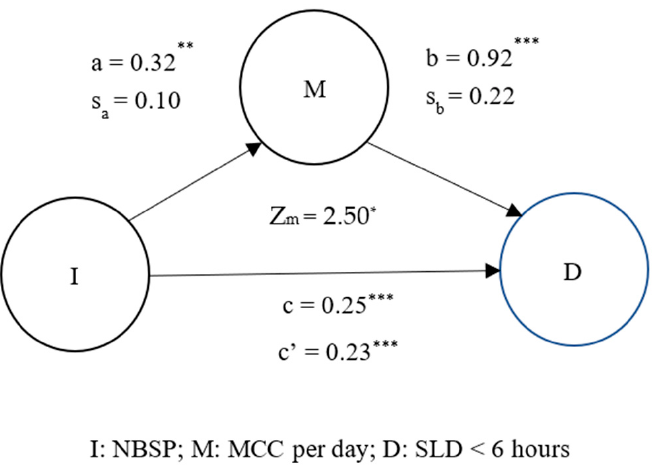
Figure 3. Mediation effect of MCC per day on NBSP and SLD < 6 h. * p < 0.05; ** p < 0.01; *** p < 0.0001; M, mediation factor; I, independent variable; D, dependent variable; c is the simple linear or logistic regression coefficient for the independent variable against dependent variable in the absence of mediation factor; c’ is the binary linear or logistic regression coefficient for the independent variable against dependent variable in the presence of mediation factor; a is the simple linear or logistic regression coefficient for the independent variable against the mediation factor; b is the regression coefficient for the mediation factor against the dependent variable in the binary linear or logistic regression model; s a and s b represent the standard deviations of a and b